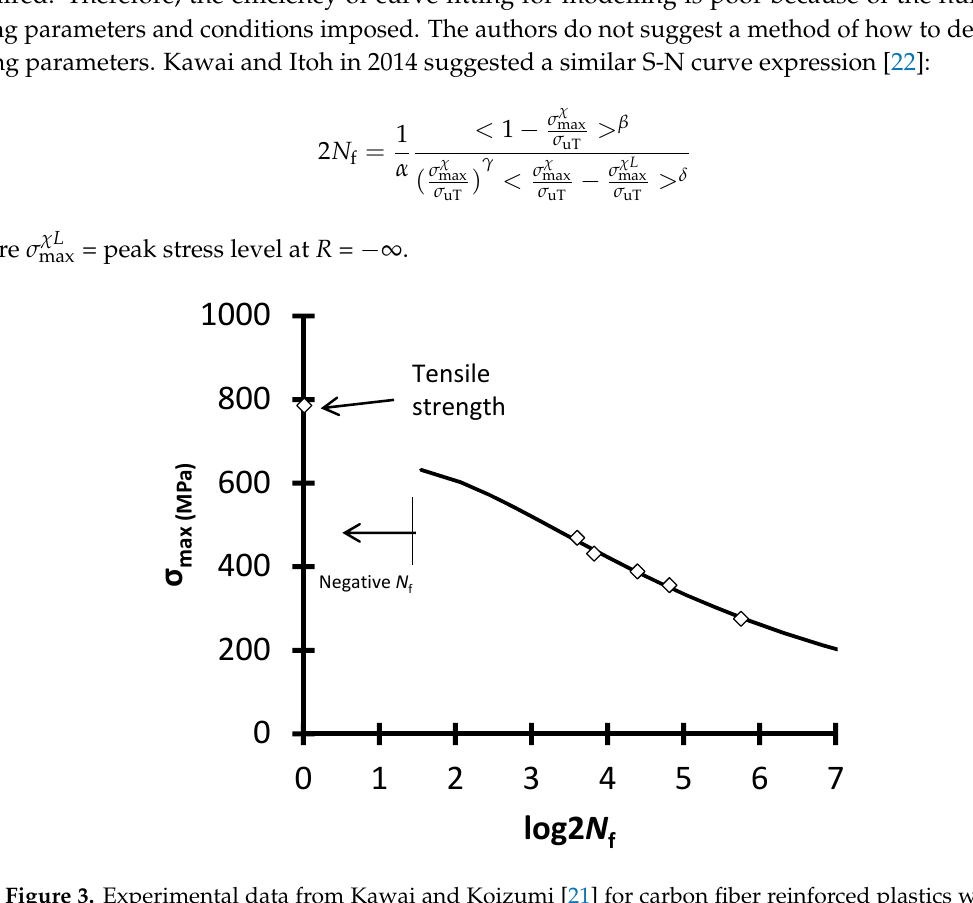
Figure 3. Experimental data from Kawai and Koizumi [21] for carbon fiber reinforced plastics with tensile strength = 782 MPa and compressive strength = 532 MPa obtained at R = − 0.68. An S-N curve was fitted according to Equation (25) using α = 0.003, β = 1, γ = 8.5, and σ B = ( σ uT + | σ uC |)/2.